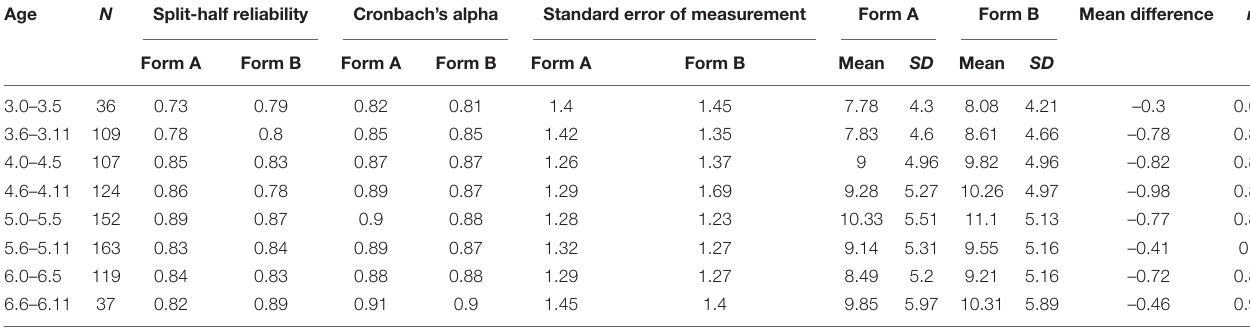
TABLE 4 | Split-half reliability, Cronbach’s α , standard error of measurement, and alternate form reliability for each 6-month age band.